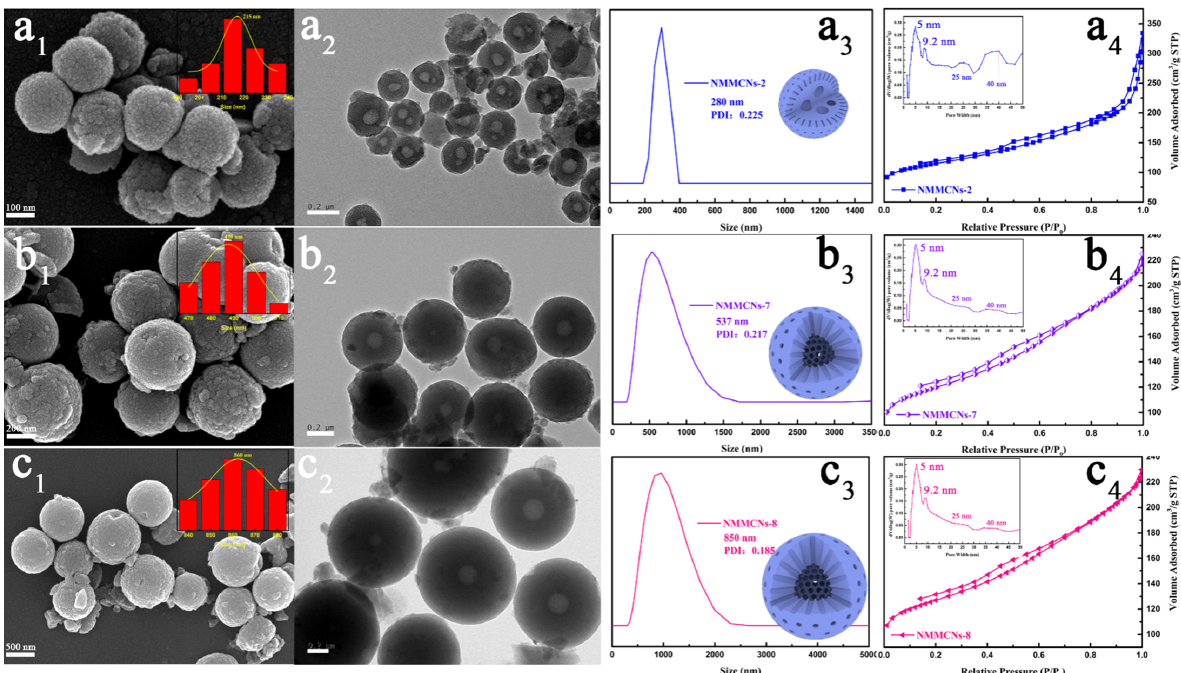
Figure 6. SEM images ( a1 – c1 ), TEM images ( a2 – c2 ), particle size distributions derived from DLS ( a3 – c3 ) and nitrogen adsorption–desorption isotherms ( a4 – c4 ), as well as the corresponding PSD curves (( a4 – c4 ), inset) of NMMCNs synthesized with different EDA contents. (Row ( a ), NMMCNs-2; Row ( b ), NMMCNs-7; Row ( c ), NMMCNs-8).